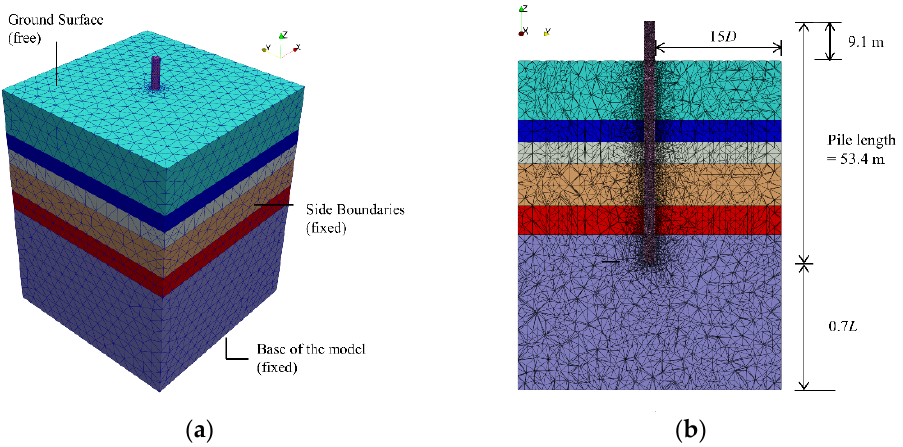
Figure 1. ( a ) Boundary conditions and ( b ) subsurface profile of the FE model.